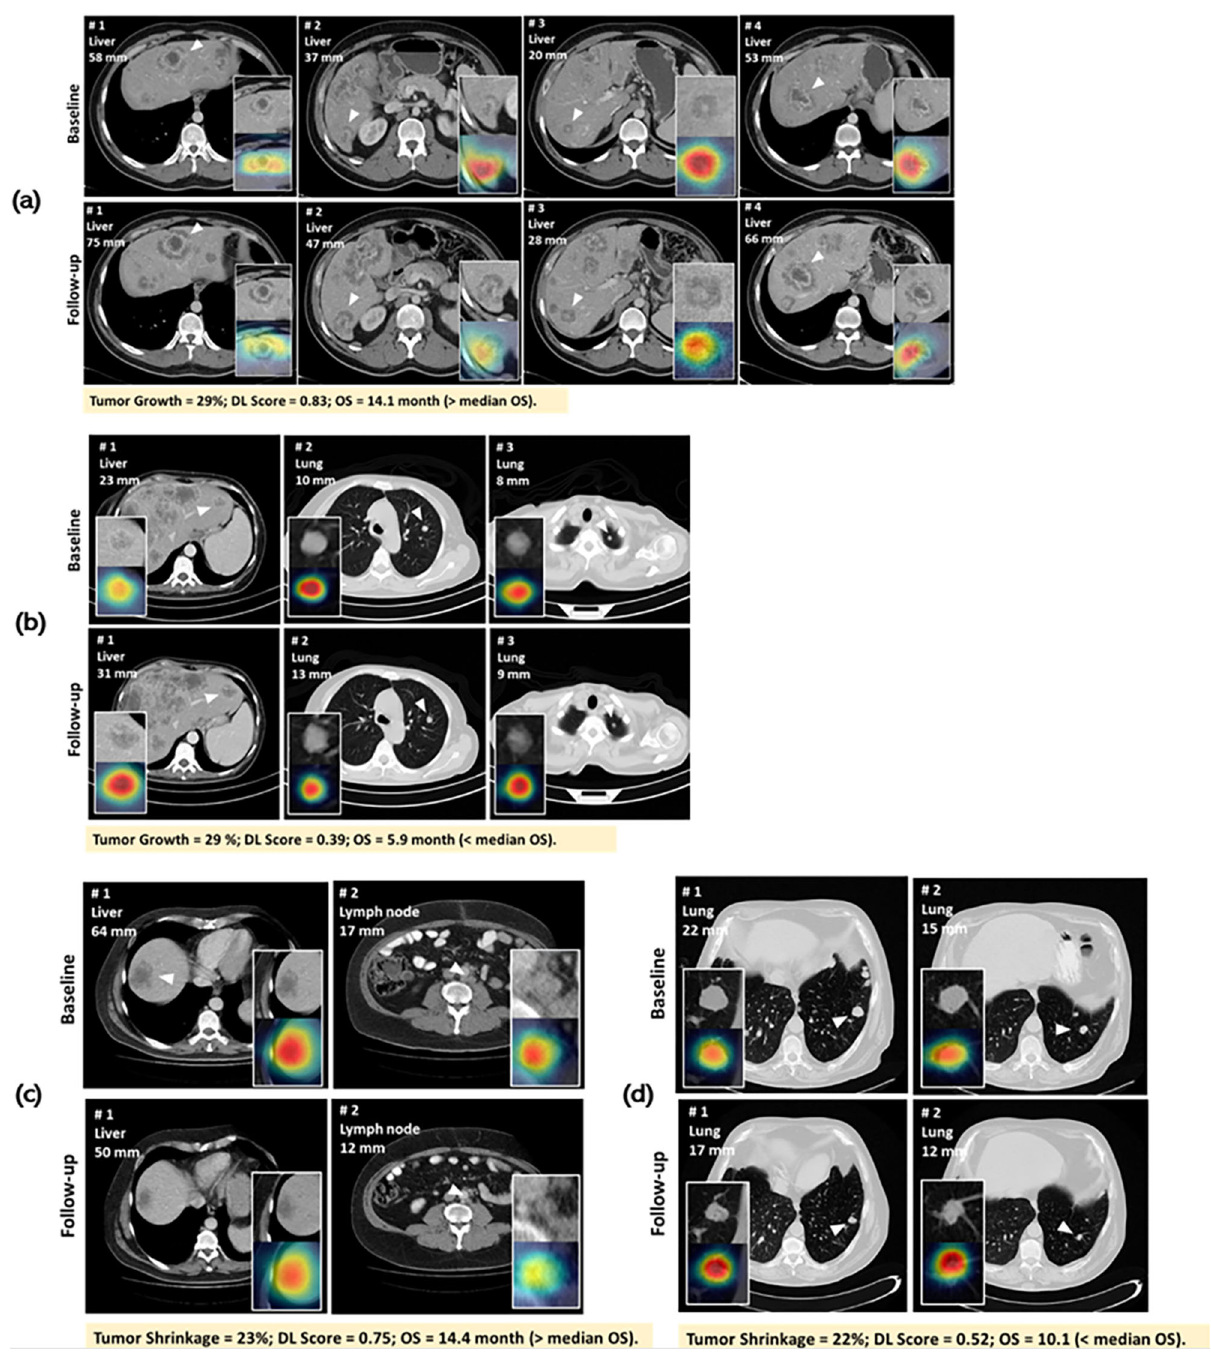
Fig. 6 Examples for attention mapping on four mCRC patients. In each picture, descriptions at the top-left corner show lesion ’ s numbering, site and size measurement, white arrows indicate lesion location, and white frames at the bottom-left/right corner show the zooming region of interest and the correspond attention mapping for the region of interest. Each picture contained two rows, of which the upper showed CT scans of baseline and the bottom showed CT scans of follow-up. Descriptions in yellow at the bottom of each picture show the tumor shrinkage, deep learning (DL) method predicting score and overall survival (OS) for the correspond patients. a , b Were patients with tumor burden increasing, while ( c , d ) were patients with tumor burden decreasing; and although patients showed similar tumor load growth/shrinkage patterns, they had varying survival well as its incremental value to traditional size-based method were assessed. In patients with both OS data and CT images at baseline and month-2 were included. addition, activation mapping technique was applied to provide visualization on Patients were randomized into discovery and test cohorts, which were used to train region of interest de fi ned by DL network to further human understanding. and validate the DL networks, respectively. The randomization was provided by Vol- PACT along with the data. The analysis of our study consisted of two phases, the training and validation phases. In the training phase, the data in the discovery cohort were further randomized into training and tuning datasets, which were used to train Datasets . The VELOUR trial is an international prospective multi-institutional network parameters and select optimal hyperparameters for the DL network, study that evaluated whether the antiangiogenic agent a fl ibercept in combination respectively. In the validation phase, the prognostic performance of DL network as with 5- fl uorouracil, leucovorin and irinotecan (FOLFIRI) could signi fi cantly